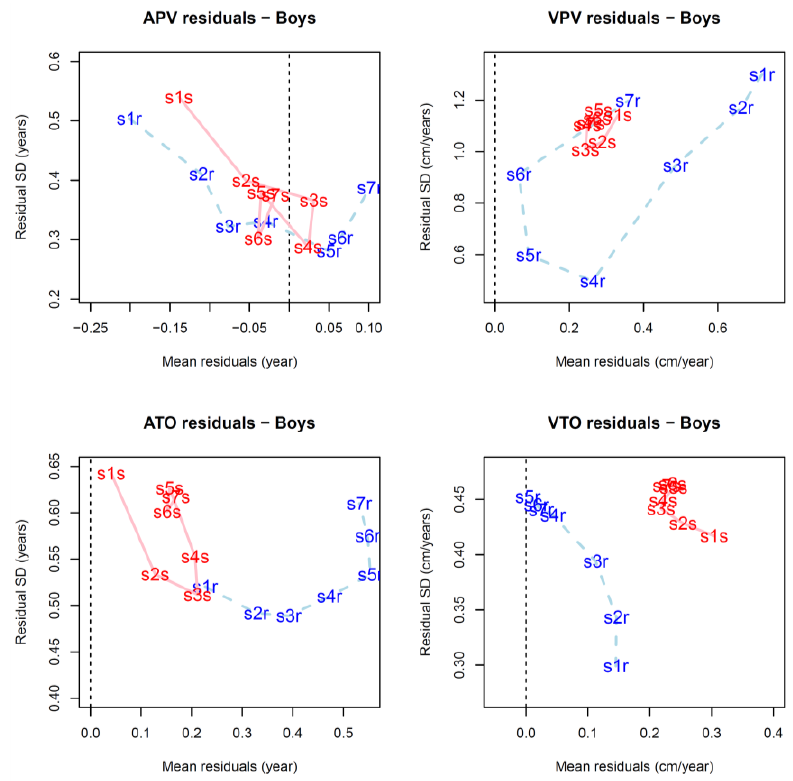
Figure 8. Residuals of the estimates of growth milestones between the FPCA (blue, dashed line) and SITAR (red, solid line) methods among boys; the standard deviations of residuals ( y -axis) are plotted relative to the mean residuals ( x -axis). Samples 1 to 7 are coded s1r to s7r (blue) for FPCA method and s1s to s7s (red) for SITAR method.